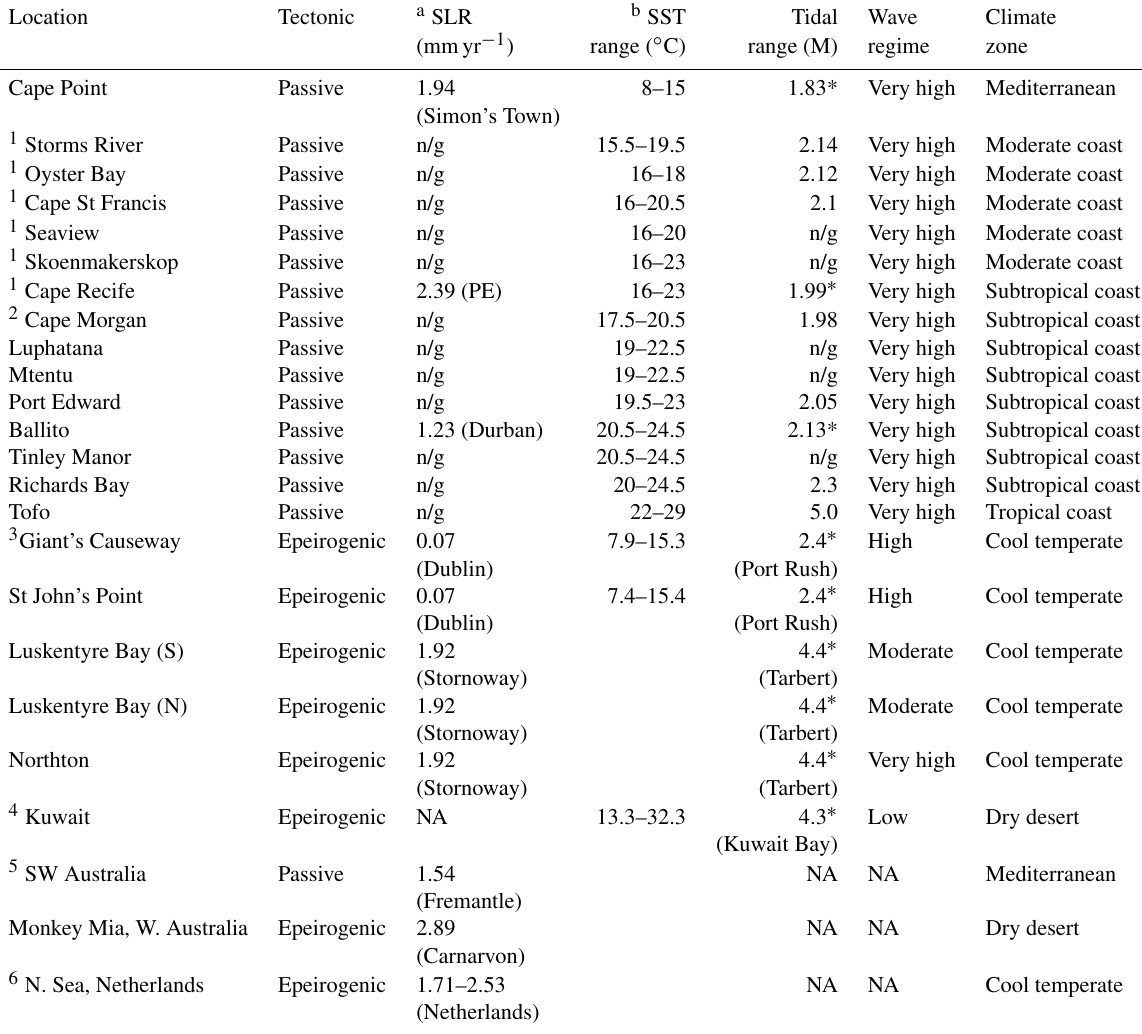
Table 4. Tectonic and oceanographic aspects of SPS localities. Tidal data from the South African Naval Hydrographic Office and British Admiralty (measured values ∗ ; Sea level rise a , and Sea surface temperature b ) and satides.co.za (modelled data)(n/g: not